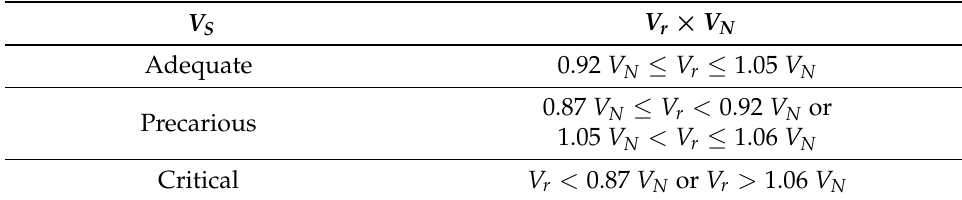
Table 3. Nominal voltage limits less than 1